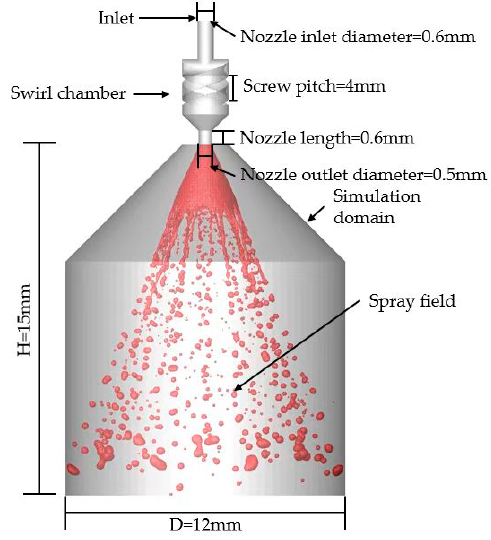
Figure 1. Physical model.